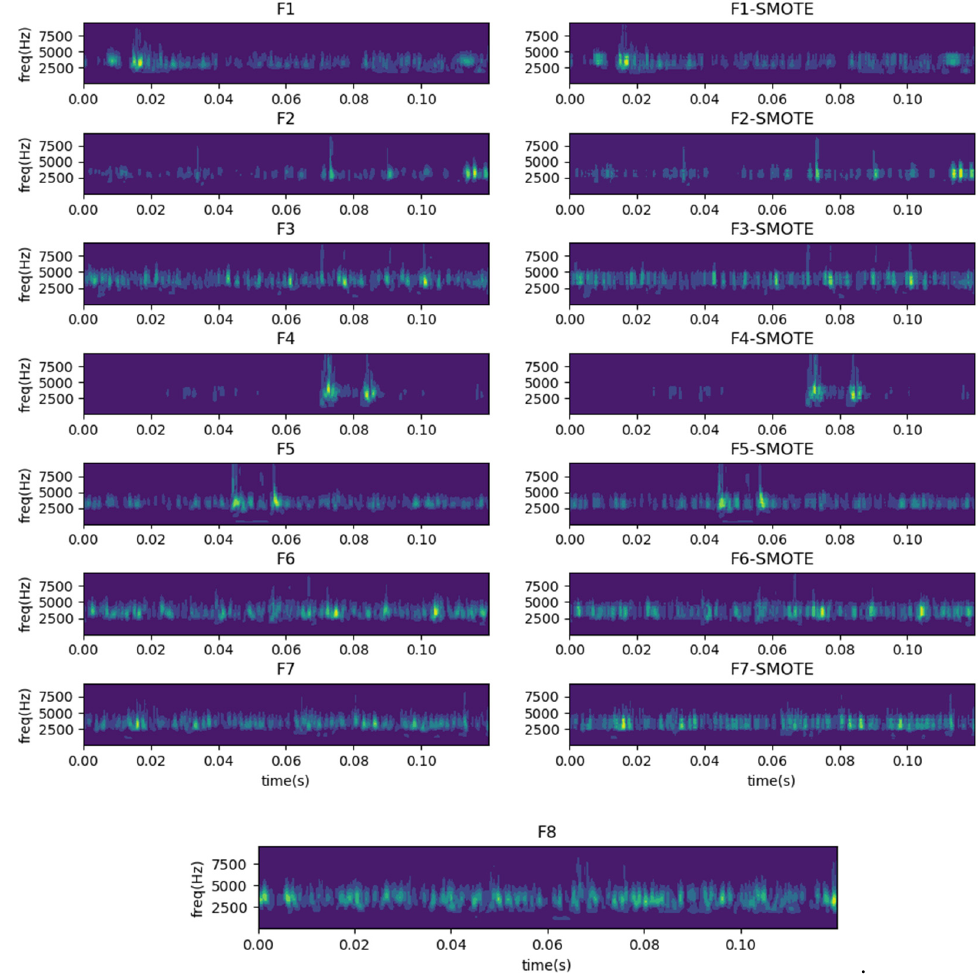
Figure 9. Time-frequency images of the original samples and generated samples. It mainly contains a healthy-bearing sample and seven fault-bearing samples, and seven generated samples.